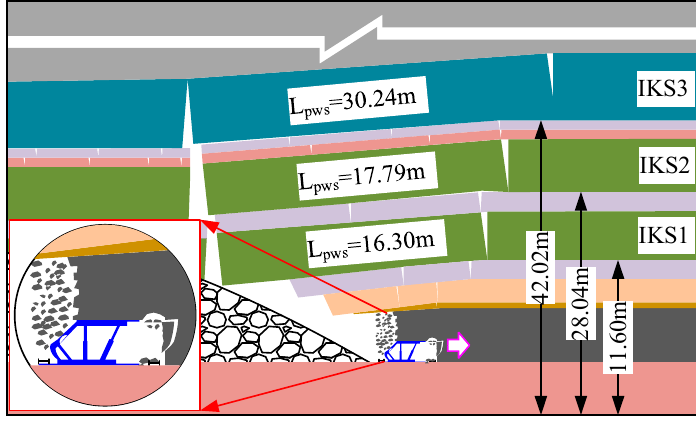
Figure 10. Diagram of overlying strata during working face mining fracture. The microseism information was systematically collected with the constant statistical step of 5 m. As illustrated in Figure 11, the microseism events were mainly distributed within the range of 0~80 m, and they decreased with distance apart from the working face. According to the decreasing trend of the energy and frequency, the curves are divided into three states: (1) The high-level stage of microseism energy and frequency around 0~20 m, in which the energy and frequency accounts for 43.34% and 40.12%, respectively, occupied a dominant role. Herein, the first and second breaking steps of inferior key strata are all within this part; (2) The decreased stage of microseism energy and frequency around 20~50 m, the value of which accounts for 32.13% and 27.12%, respectively, indicating that the third inferior key stratum is within this range; (3) The lower stage of microseism energy and frequency ranging from 50 m to 80 m, which accounts for 24.50% and 32.16%, respectively. In the first two stages, the proportion of frequency decreased compared with the energy, indicating that the first two stages are mainly dominated by high-energy microseism events. Note that the microseism energy increases significantly when the main key strata breaking distance reached 67.96 m. In summary, the activity of IKS1 and IKS2 is much higher than that of IKS3 and MKS. That is, the microseism data within the 0~20 m zone can reflect the motion state of IKS1 and